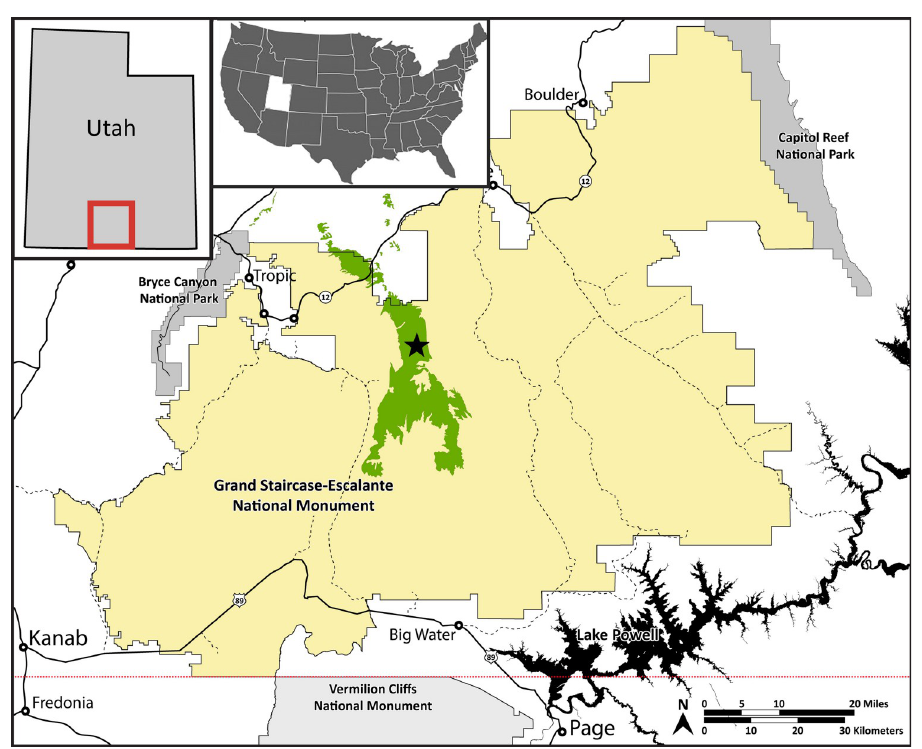
Fig 1. Map of the Grand Staircase-Escalante National Monument. The Kaiparowits Formation outcrop is green. Solid yellow denotes newly reestablished monument boundaries. DMNH loc. 4150, the Lost Valley locality, is denoted by a star. Adapted from Crystal et al.